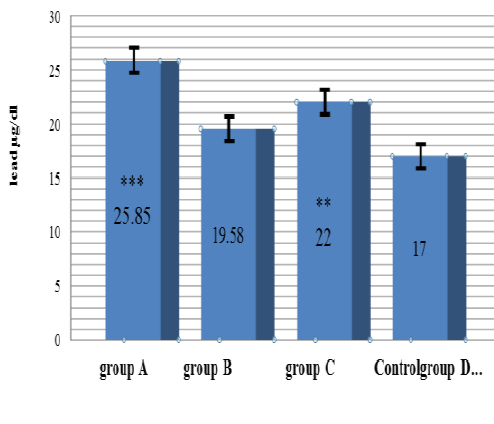
Table (3): Comparison of blood lead levels between adults and children groups.